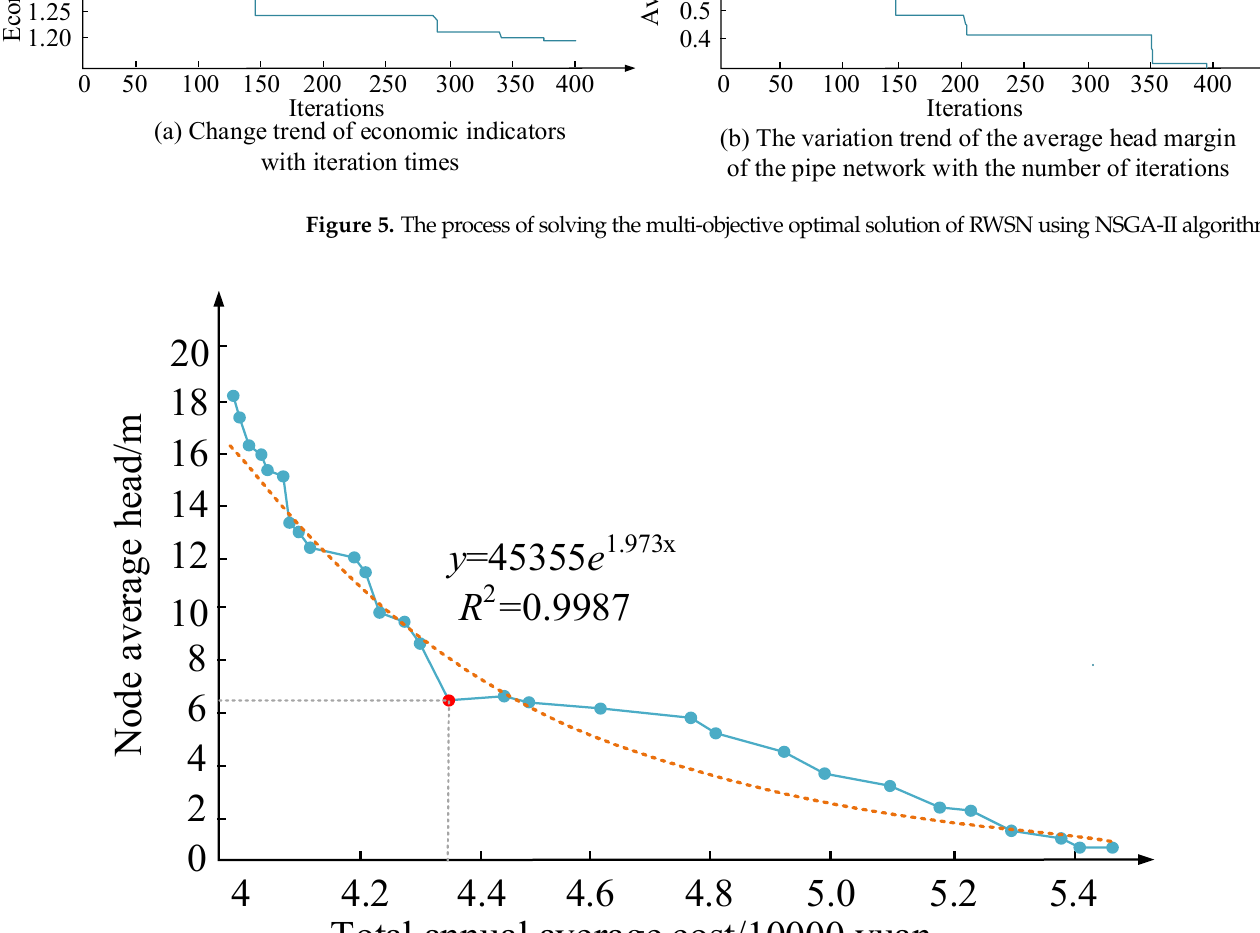
Figure 6. Multi-objective Pareto solution of RWSN based on NSGA-II algorithm. Figure 7 illustrates the rural water supply pipeline optimization process combining the LM algorithm and NSGA-II algorithm. From Figure 7a,b when the iterations achieve about 210 generations, the RWSN’s economy is optimal; When the iterations achieve about 325 generations, the RWSN’s average head margin of the nodes is the best, that is, the RWSN’s reliability is the best at this time. From Figure 7c, the NSGA-II combined with LM takes less time at this time. Thus, the validity of the LM algorithm and the feasibility of NSGA-II for solving the optimization model of RWSN are verified. Subsequently, the experimental results shown in Table 1 can be obtained by calculating the hydraulic power of the water supply network through Equations (1)–(3) and